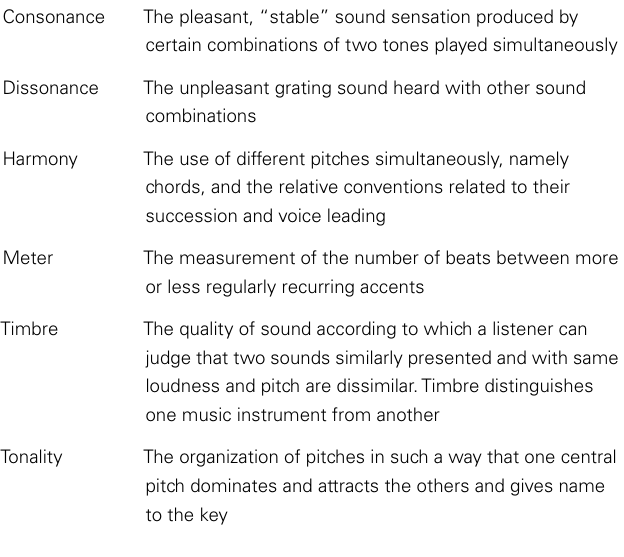
Table 2 | Glossary of music terms used in the